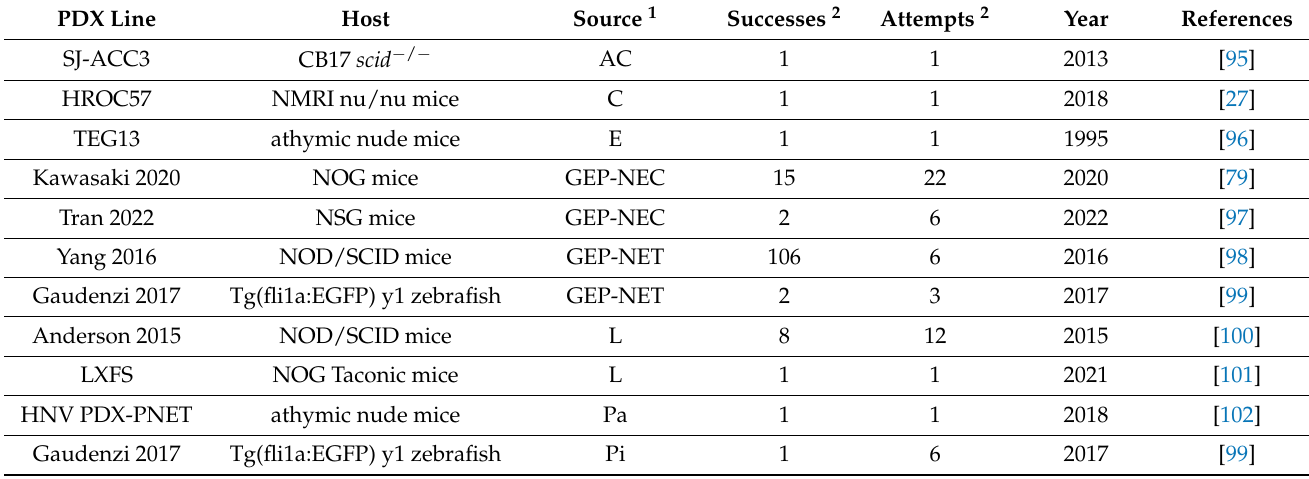
Table 3. Neuroendocrine neoplasm patient-derived